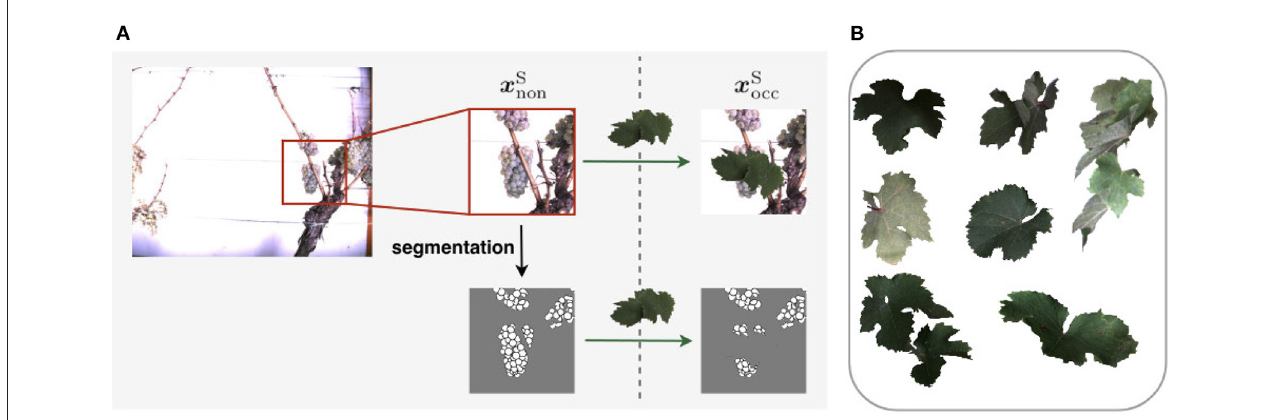
FIGURE 5 | (A) Visualization of synthetic data creation. The visualization indicates the use of an artificial leaf to calculate the corresponding mask of x S occ of the occluded domain instead of using the segmentation mask prediction based on the occluded RGB-image.Exemplary leaves used for data augmentation. (B) Shows exemplary leaves used for data augmentation.